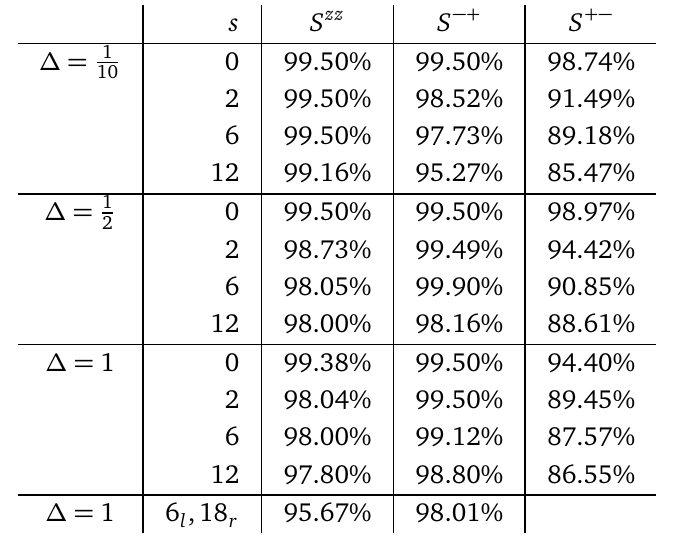
Table 1: Sum rule saturations for all data obtained from the ABACUS algorithm at N = 200 and M = 50 for various values of the anisotropy and the momentum shift in the Fermi seas. The bottom row shows the saturations for an asymmetric shift of the quantum numbers. In particular, for increasing momentum split s , the energy of the reference state increases with respect to the ground state, opening up the possibility to populate branches of the spec- trum at negative energy. Moreover, the incommensurate points (at zero energy) start moving in momentum. Broad continua of the spectrum remain with sharply defined thresholds, such that the Tomonaga-Luttinger liquid paradigm retains its